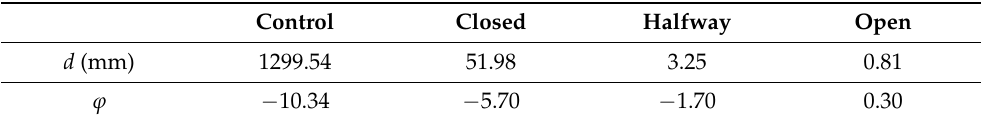
Table 2. Sediment diameter for incipient